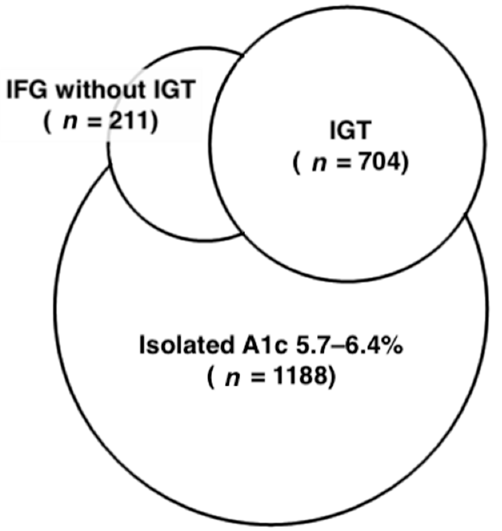
Figure 1. Venn diagram representing different domains of prediabetes categorized by glycated hemoglobin A1c (A1c) of 5.7–6.4%, impaired fasting glucose (IFG), and impaired glucose tolerance